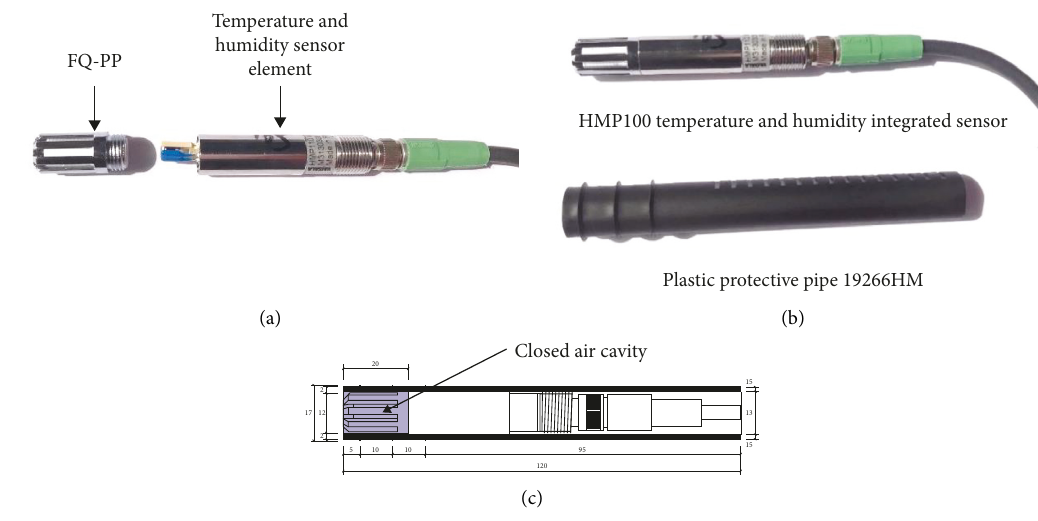
Figure 3: The shape and size of the temperature and humidity measurement equipment inside the wall. (a) FQ-PP (built-in filter membrane with 0.2 μ m pore), temperature, and humidity sensor element. (b) HMP100 temperature and humidity integrated sensor, plastic protective